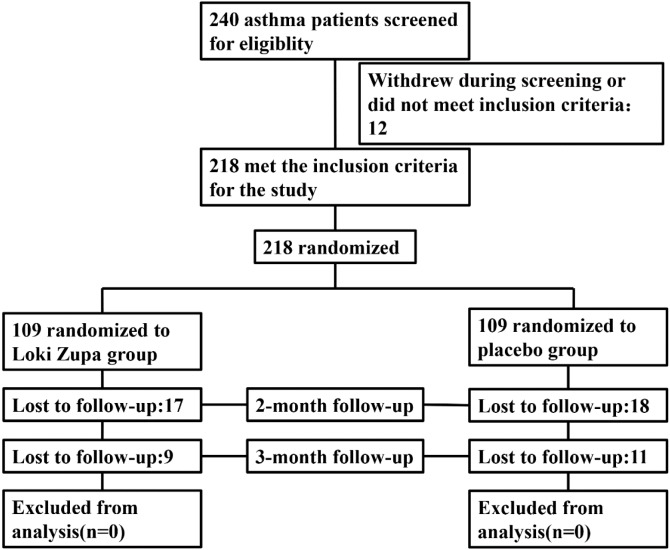
Study flow chart.